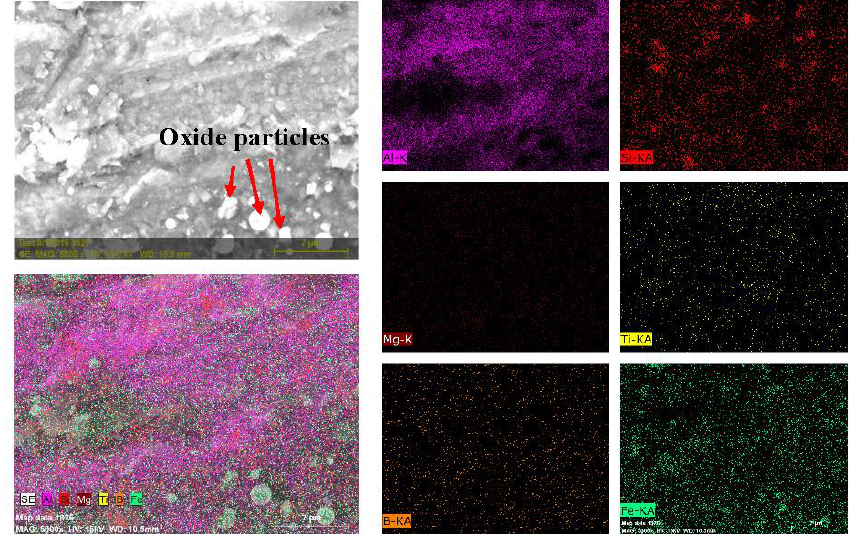
Fig. 15. EDS mapping of Al-Si-Mg/TiB 2 composites at 12 h ageing time, 2.5 m/s sliding speed and 14.71 N.